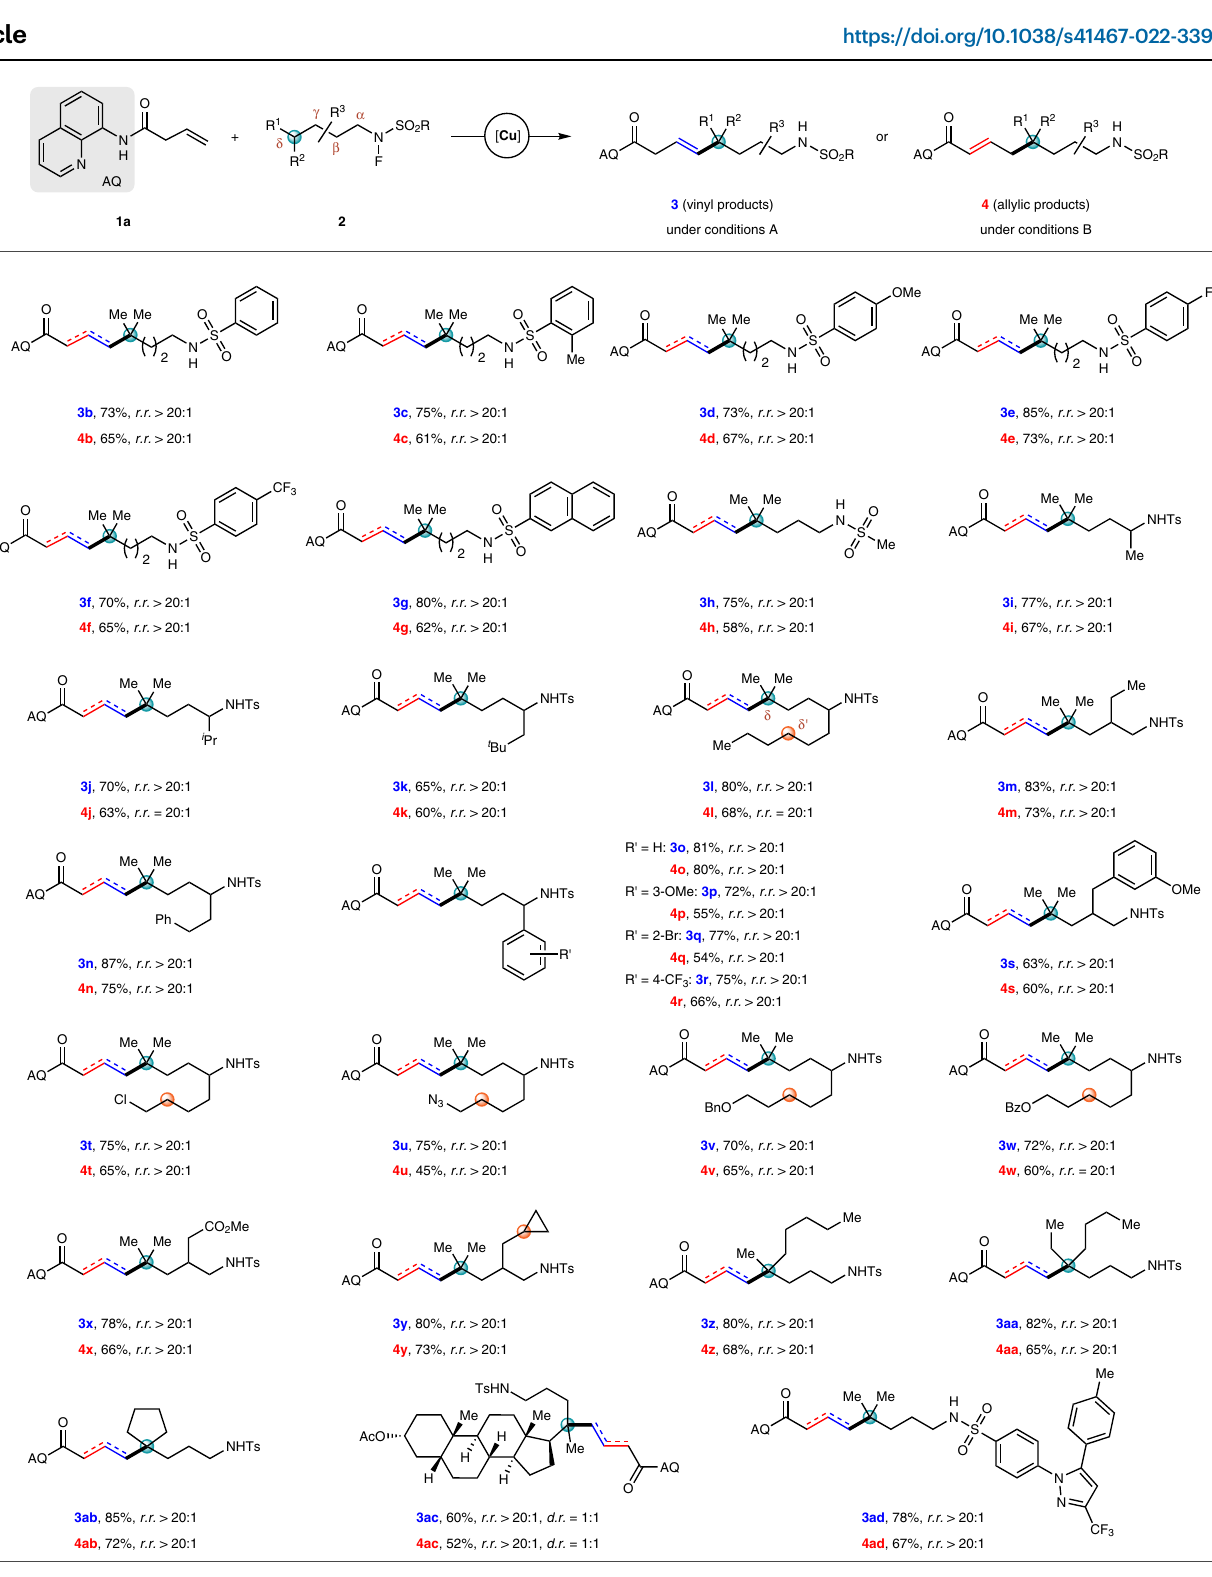
(0.02mmol), Zn(OAc) 2 (0.08mmol), and TFA (0.40mmol) in benzene (2.0mL) at 90°C for 4h. Isolated yields are shown. E / Z is >20:1 if not stated otherwise. TFA tri fl uoroacetic